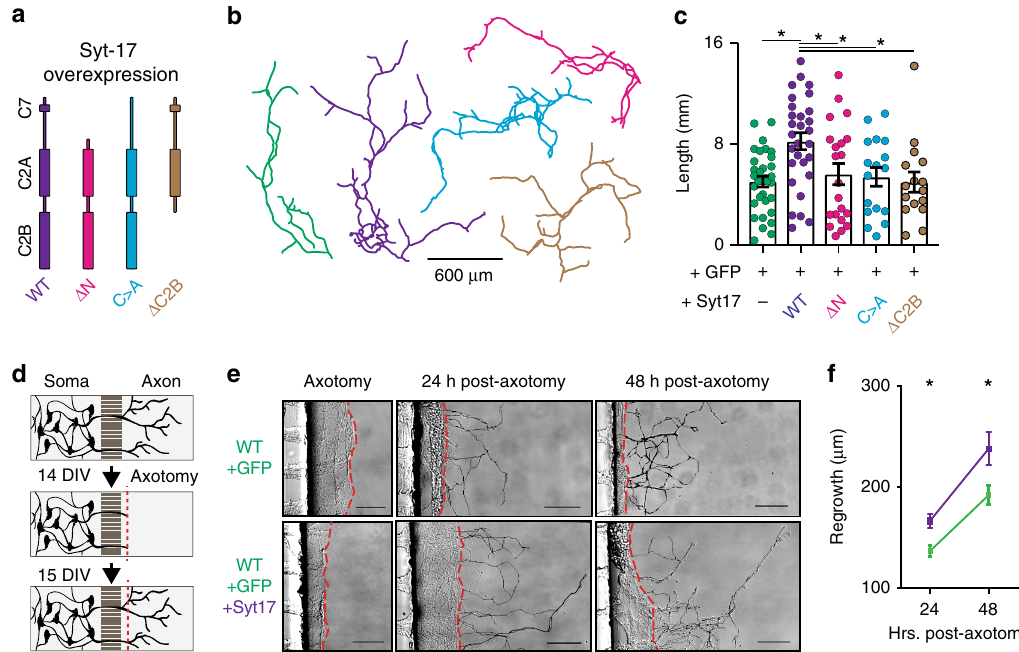
Fig. 3 Syt-17 overexpression increases axonal length and facilitates regrowth after injury. a Overexpression in WT neurons of WT syt-17 (purple), and mutants either lacking the N-terminal domain (magenta), with the N-terminal cysteine patch mutated to alanines (blue), or lacking the C2B domain (brown), relative to control neurons (green). b Measurement of axonal length in neurons overexpressing our syt-17 constructs, or neurons expressing only GFP (green). Measurements were performed identically to Fig. 2. c Overexpression of syt-17 increased axon length ( F 4,111 = 4.79, p = 0.001, post-hoc of overexpression vs. control: t 63 = 3.89, p = 0.0007, r 2 = 0.193, mean wt = 5.05 ± 0.42 mm, mean overexp = 8.25 ± 0.67, mean delta-N = 5.64 ± 0.85, mean C>A = 5.42 ± 0.75, mean delta-C2B = 5.01 ± 0.8, N wt = 33, N overexp = 29, N delta-N = 21, N C>A = 17, N delta-C2B = 16), and this effect was abolished in either of the N-terminal mutants or the C2B deletion (post-hoc t -tests vs. control p > 0.1). d Diagram of a micro fl uidic culture device, illustrating axons traversing the microchannels. Following mechanical axotomy, processes re-extend into the axon chamber. e Representative DIC images of micro fl uidics with neurons virally expressing control or syt-17 lentivirus after axotomy. Regrowing axons are traced in black. Scale bar indicates 50 µ m. f Axons are signi fi cantly longer in cells overexpressing syt-17 at both 24 (t 608 = 3.084, p = 0.002, r 2 = 0.015, mean wt = 139.85 ± 5.27 μ m, mean overexp = 164.83 ± 6.05, N wt = 290 and N = 320) and 48 ( t = 2.632, p = 0.008, r 2 = 0.023, mean = 192.33 ± 9.24, mean = 238.3 ± 16.27, N = 174 and N = 118) hours overexp 290 wt overexp wt overexp after axotomy. All error bars indicate